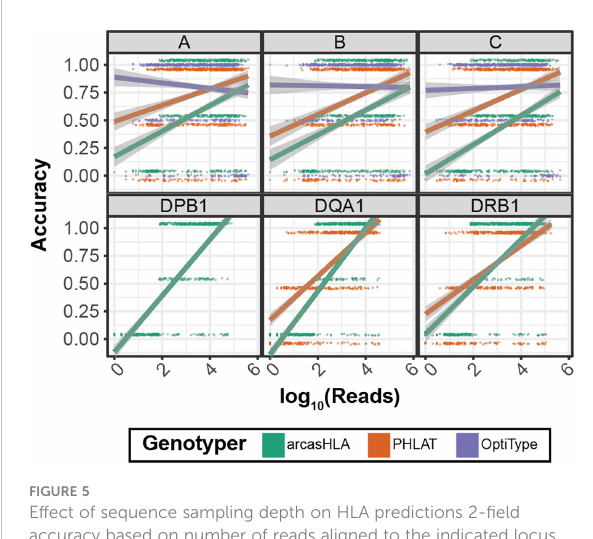
FIGURE 5 Effect of sequence sampling depth on HLA predictions 2- fi eld accuracy based on number of reads aligned to the indicated locus. Raw sequencing data sampled to 100%, 10%, 1%, and 0.1% of original sample read total. Points represent individual samples offset from {0, 0.5, 1} to distinguish genotypers. Trend lines represent linear regression using log transformed reads with ribbon representing 95% CI.